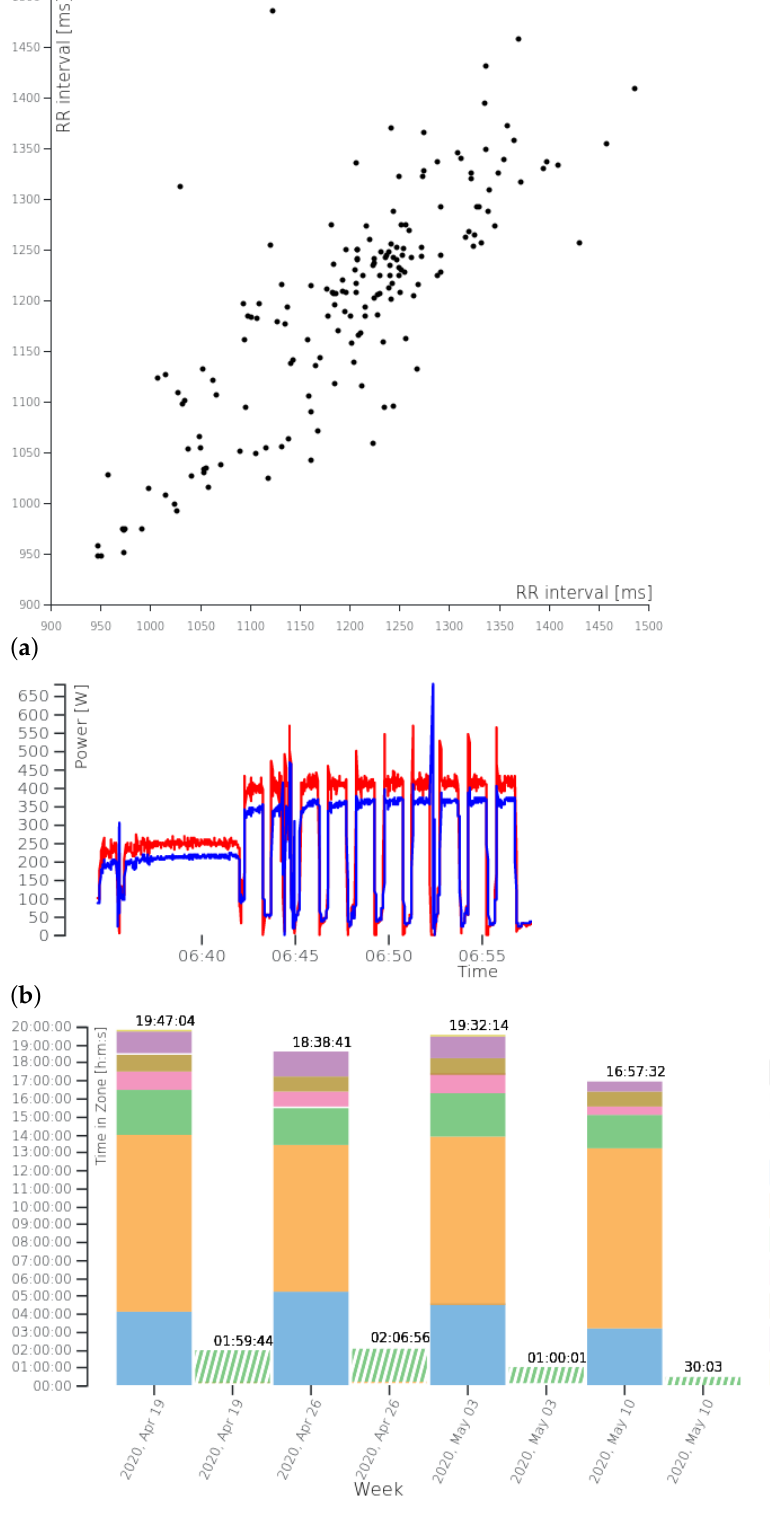
Figure 3. ( a ) Example of a Poincaré plot as shown by the Web-Frontend. ( b ) Example of a line chart as shown by the Web-Frontend. ( c ) Example of a report as shown by the Web-Frontend. Example charts generated by the